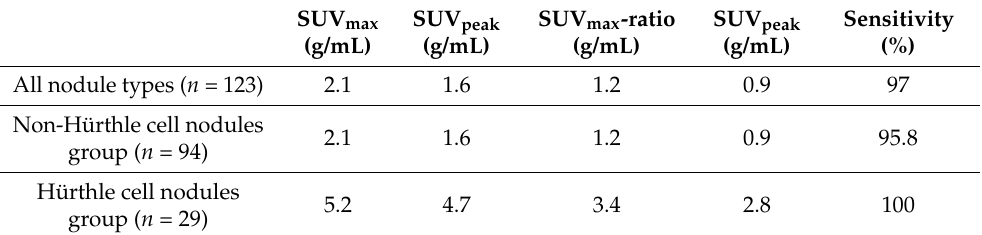
Table 2. Quantitative parameter cut-off values and their respective sensitivity in discriminating between malignant and benign thyroid nodules in three different groups (all nodule types, non- Hürthle and Hürthle cell